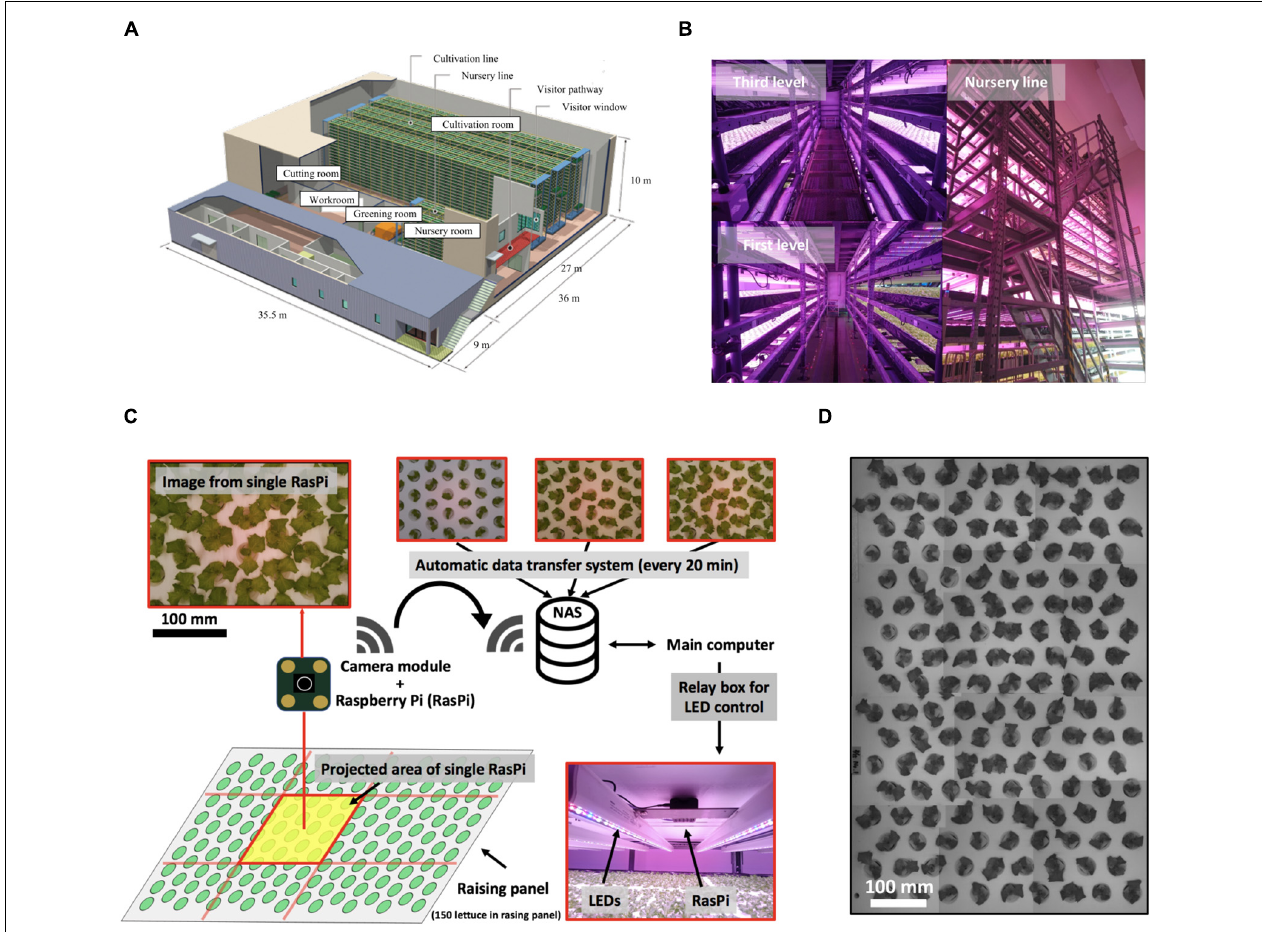
FIGURE 1 | Multiple plant imaging (MPI) system in commercial plant factory. (A) Production line of commercial plant factory in Osaka Prefecture University. Successive operations, including greening, nursing, cultivation, and cutting, are performed. (B) Nursing room. This room has three levels (left-hand upper figure shows the third level. The lower figure shows the first level). This nursery line (right-hand figure) has a capacity to accommodate 10 5 seedlings. (C) MPI system for acquiring feature values for each seedling based on time-series photographs captured on the nursing line. (D) Simultaneous measurement of seedlings on nursing panel using MPI